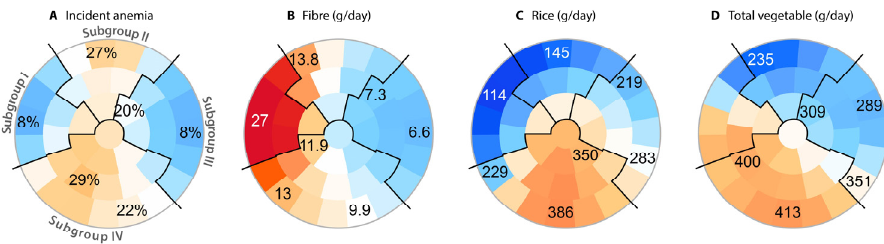
Figure 2. The data-driven self-organizing map (SOM) with subgroup boundaries, coloured according to subtype averages of four different traits. On each colouring from A – D , a particular individual resides in the same place, as one would expect for colourings of a geographical map of a city, for example. The colours were created by averaging over the local residents within the subdivisions that each represent a single data-driven subtype. The numbers on the map indicate the numerical averages for selected subtypes. Table 4. Subgroup ‐ specific risk factors for incident anemia during five years of follow ‐ up (Figure 1F,L). 1